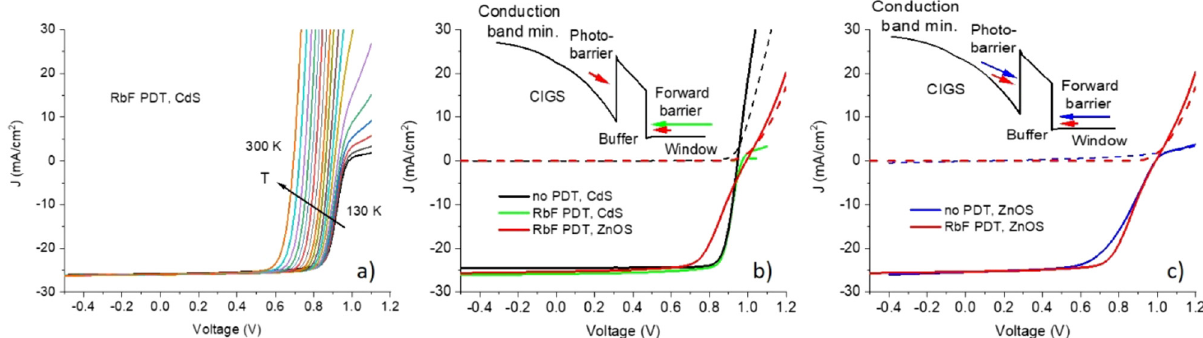
Fig. 4. (a) Light current – voltage curves for a RbF-PDT/CdS sample at different temperatures. (b) and (c) Light and dark current – voltage curves at T =130 K with descriptive band diagrams of the conduction band zoomed at the